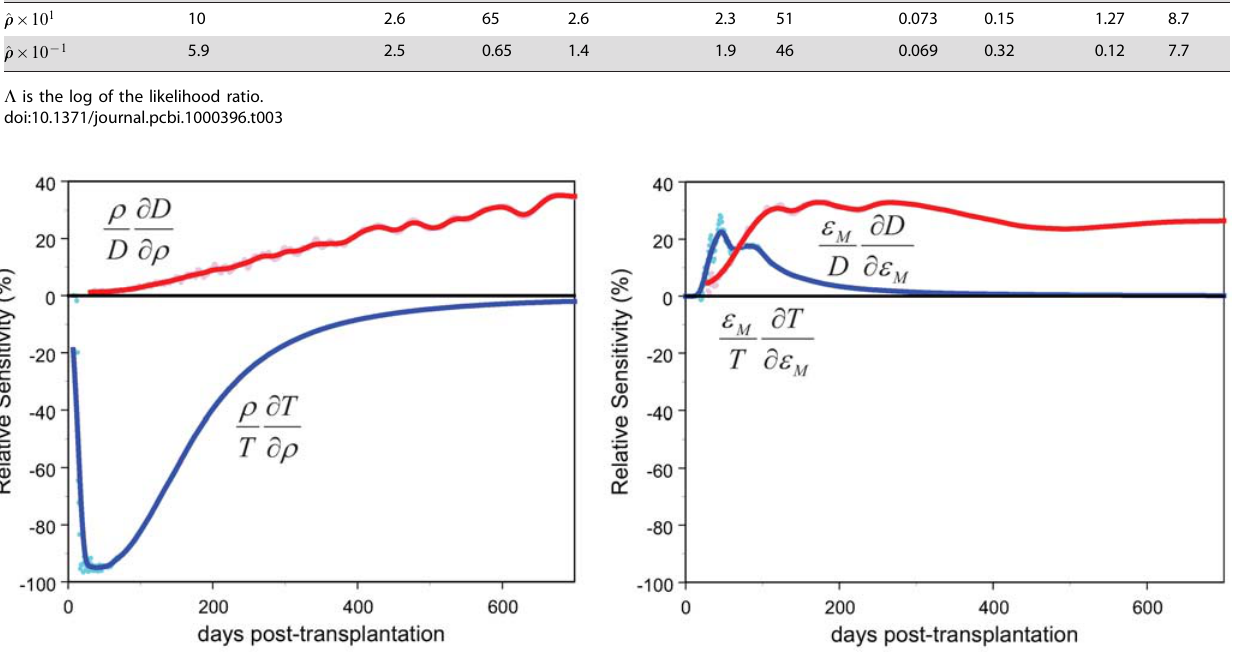
PLoS Computational Biology |